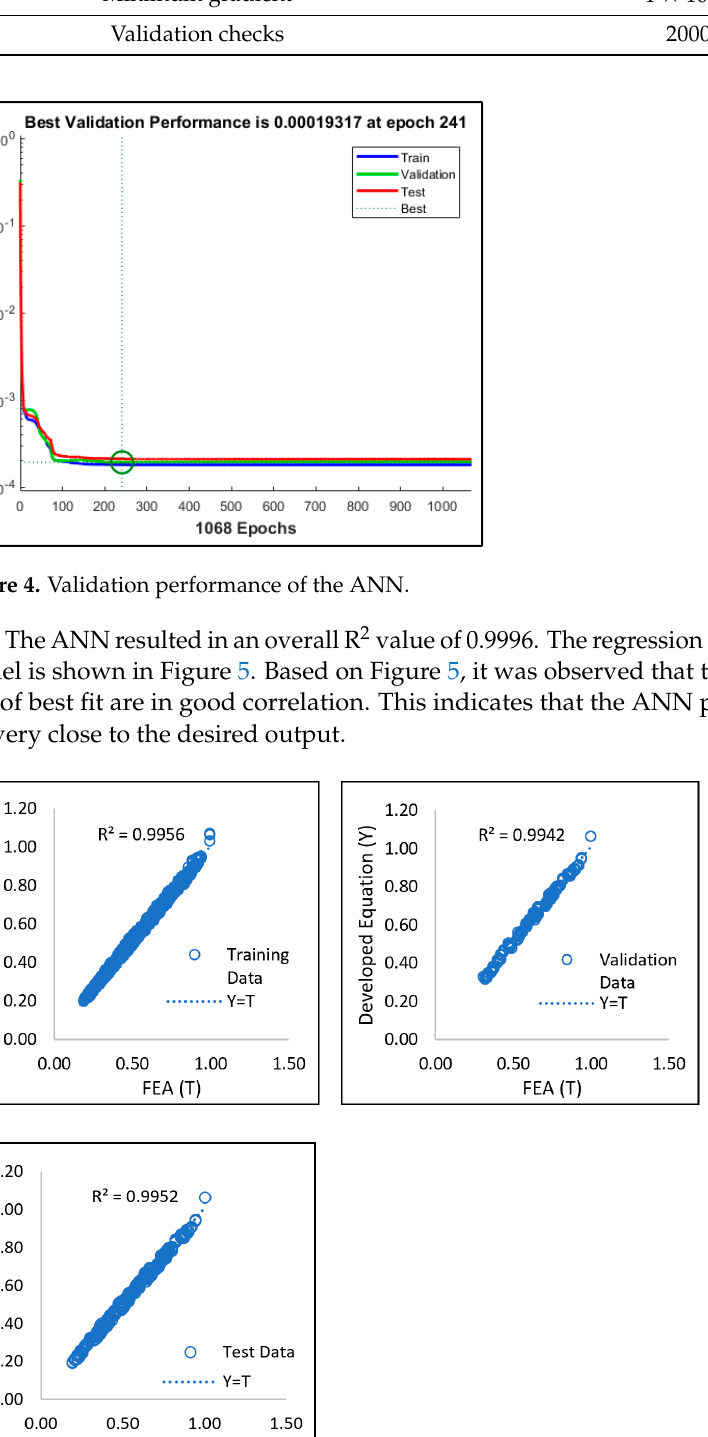
Table 9. Mean absolute error (MAE), MSE, and R 2 values of the model for training, validation, and test phase. Phase